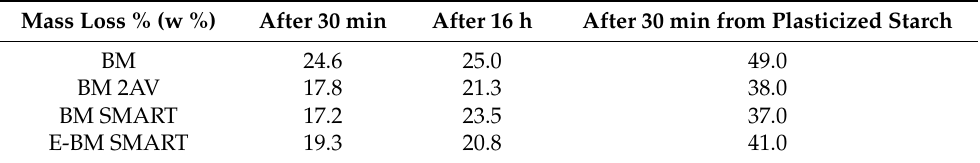
Table 3. Mass percentage of release from film in water at different